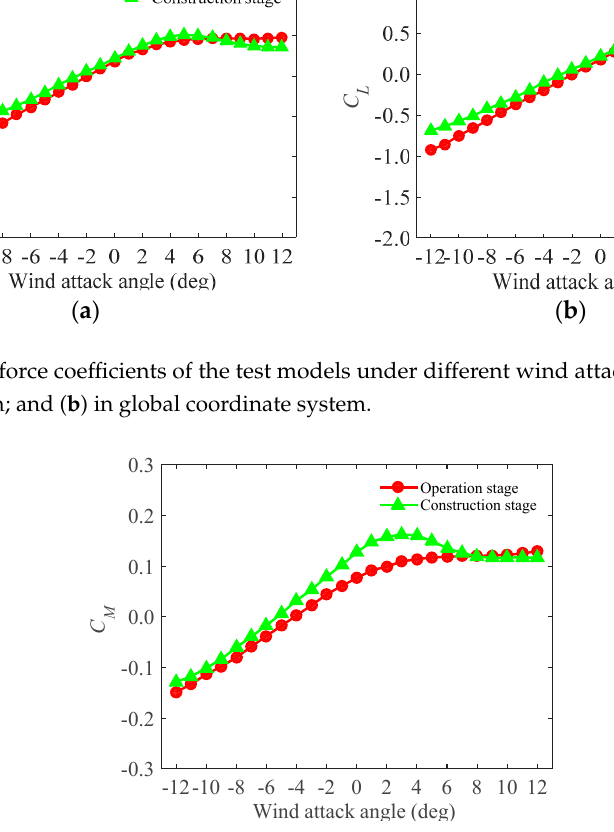
Figure 7. The moment force coefficients of the test models under different wind attack angles.